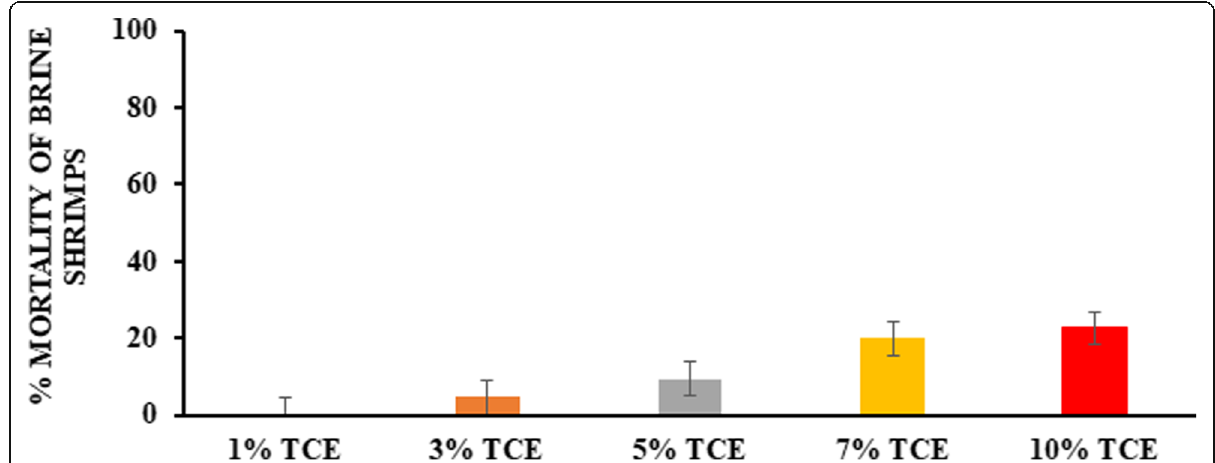
Fig. 5 Percentage mortality of brine shrimps after 24 h of exposure to the TCE